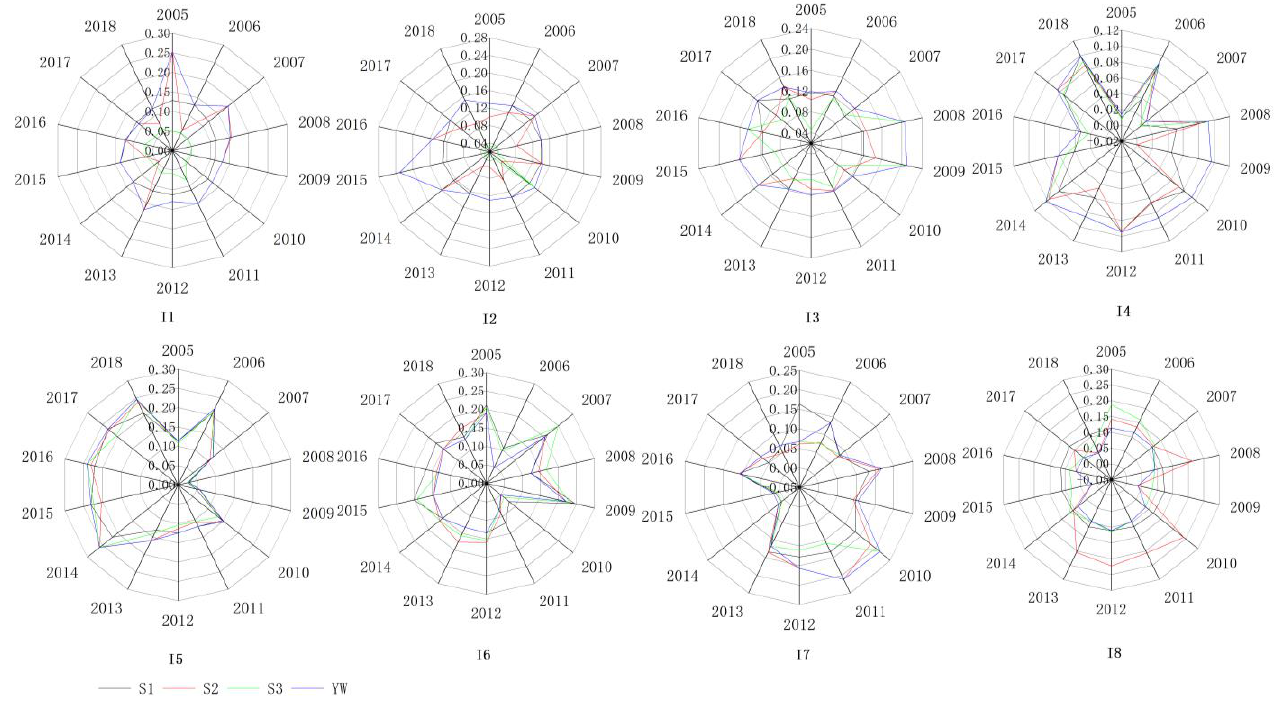
Figure 4. Dynamic weights of each indicator of China’s energy resilience.